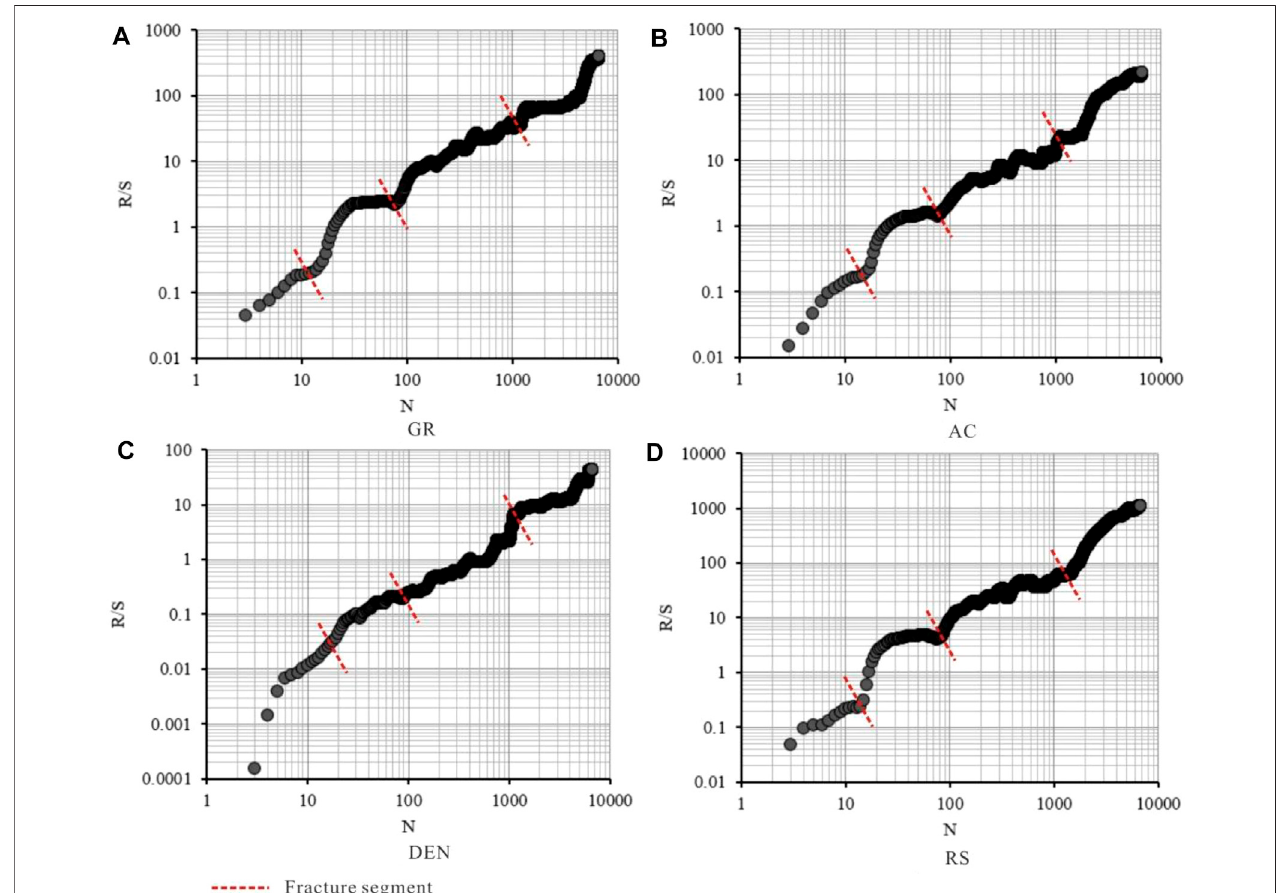
FIGURE10| CorrelationbetweenR/SandNofdifferentfracture-sensitiveloggingparametersandtheircouplingrelationshipwithfracturesegment. (A) GRlogging series; (B) AC logging series; (C) DEN logging series; (D) RS logging series. GR-natural gamma; AC-longitudinal wave time difference; DEN-rock density; RS-shallow lateral